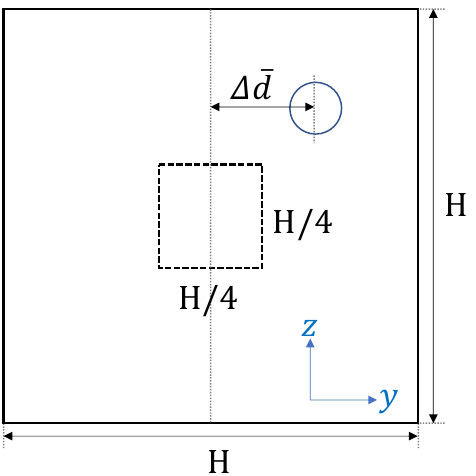
Figure 1. Schematic view of the time history of the ensemble-averaged distance ∆ d ( t ) between the particle and the centerline of the computational